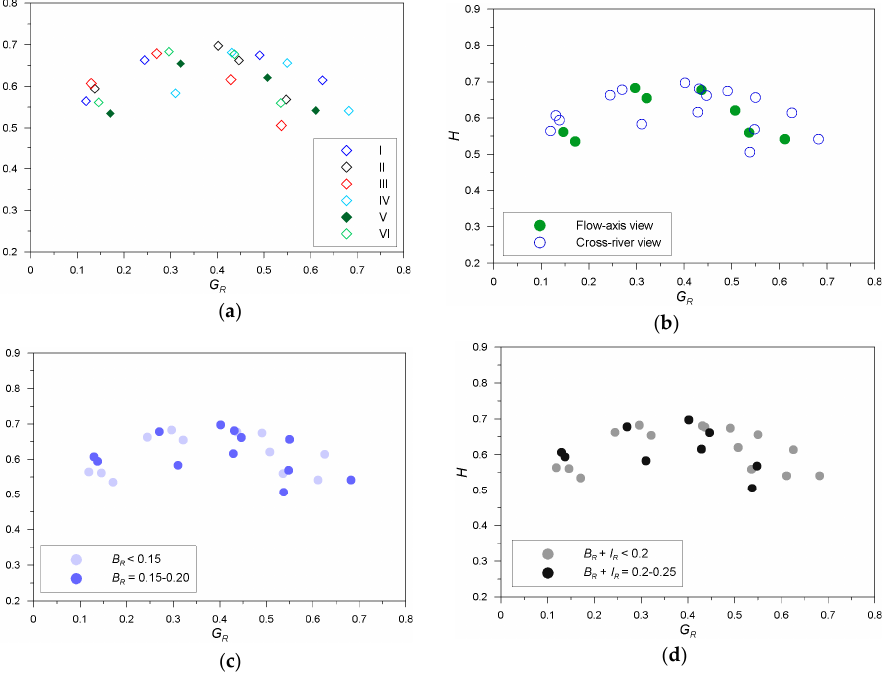
Figure 7. Relationship between harmony ( H) and the ratio of visible greenery ( G R ) for different sites and views, at various values of the ratio of visible buildings B R , and the proportion of visible buildings and infrastructure ( B R + I R ). ( a ) Different sites. ( b ) Different views. ( c ) Various values of proportion of visible buildings B R . ( d ) Various values of proportion of visible buildings and infrastructure ( B R + I R ).